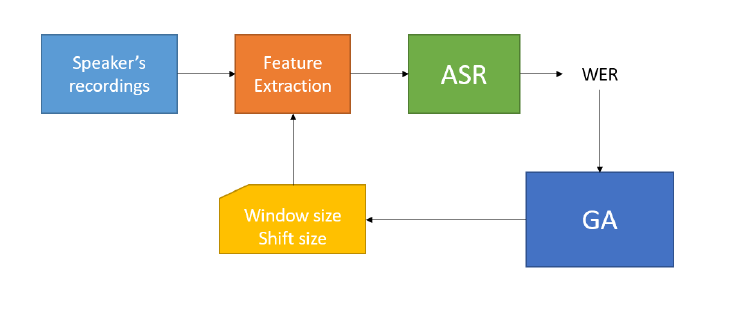
Figure 1. Block diagram of the experiment 1 working flow.